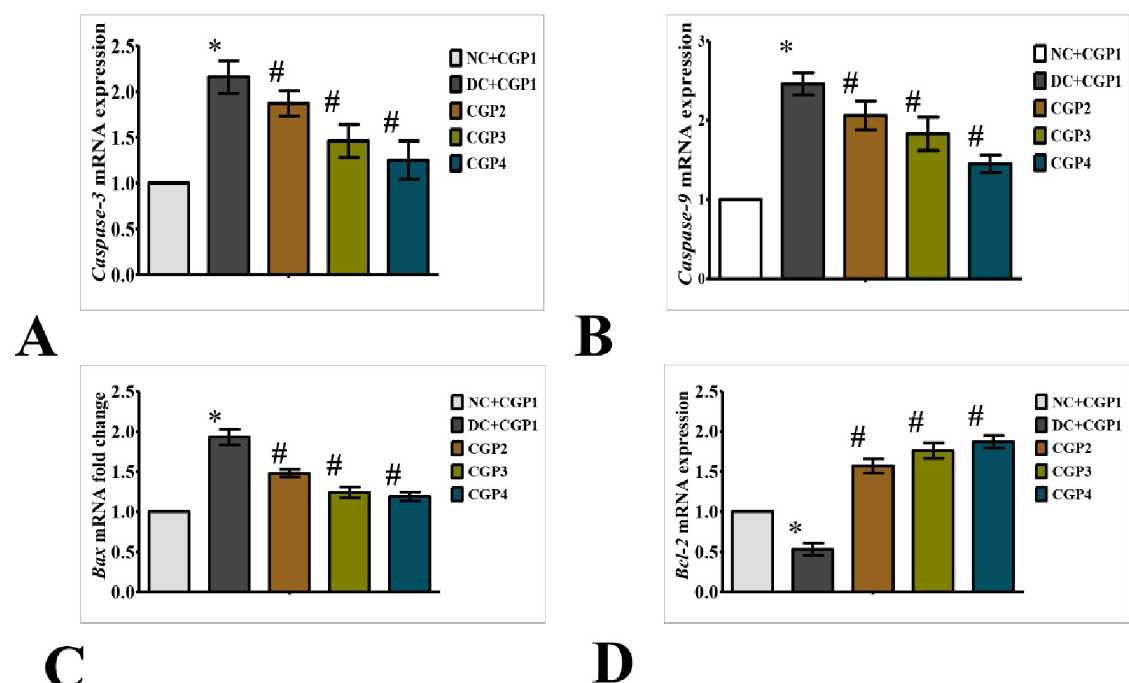
Fig 7. Effect of GC-AgNP CGPs dressing on apoptosis pathway in diabetic rats. Relative mRNA expression of (A) Caspase-3; (B) Caspase-9; (C) Bax; (D) Bcl-2; NC+CGP1: Normal control dressed with blank cotton gauze; DC+CGP1: Diabetic control rats dressed with blank cotton gauze; CGP2: Diabetic rats dressed with 13.06 μ M gallocatechin and silver nanoparticle (GC-AgNP) impregnated cotton gauze patches (DC+ 13.06 μ M CGP2); CGP3: Diabetic rats dressed with 26.12 μ M gallocatechin and silver nanoparticle (GC-AgNP) impregnated cotton gauze patches (DC+ 26.12 μ M CGP3). CGP4: Diabetic rats dressed with silver sulfadiazine (DC+AgS) impregnated cotton gauze patches. Data were expressed as mean ± S.E.M (n = 6). � p < 0.05 compared to control, # p < 0.05 compared to